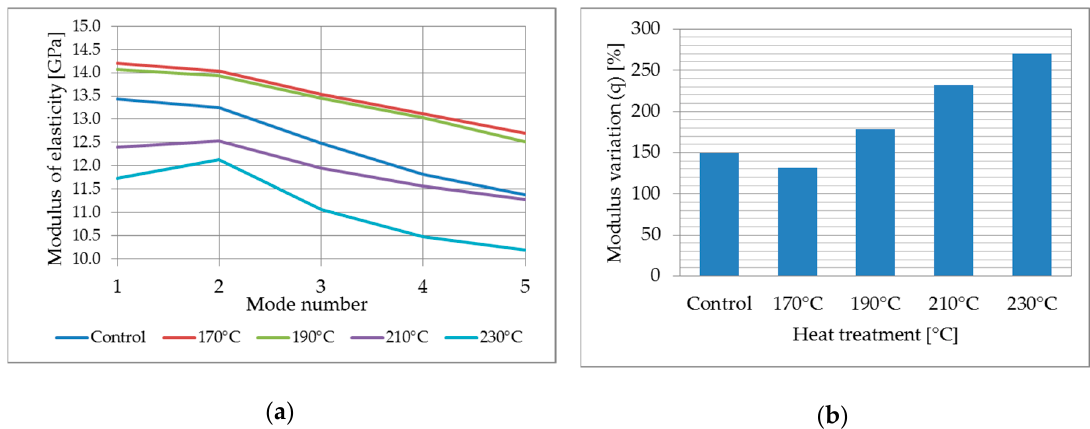
Figure 3. ( a ) Modal evaluated values of modulus of elasticity of heat-treated structural timber; ( b ) the coefficient of variation of the moduli difference in-between vibration modes (q-coefficient) of heat-treated wood.